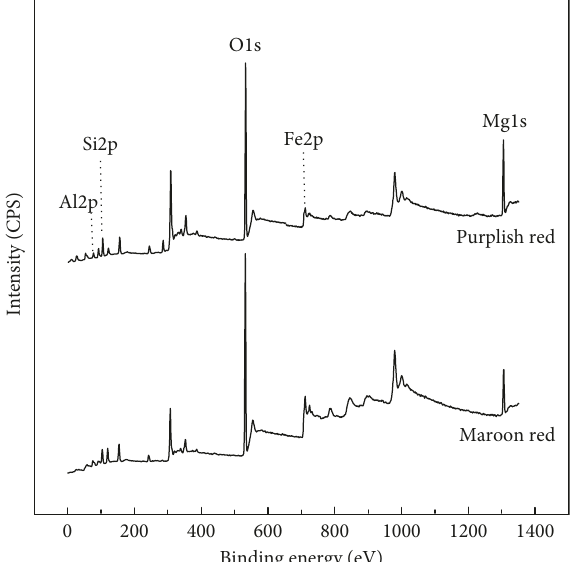
Figure 5: X-ray photoelectron spectrum of the garnet